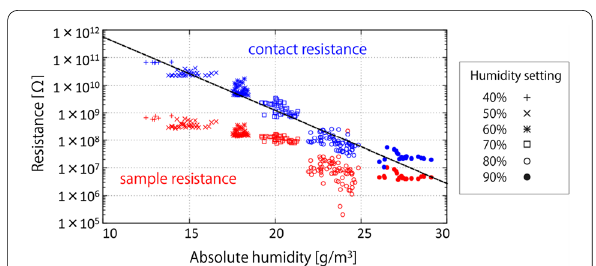
Any data outside the range of (mean) as outliers, and the statistics were recalculated